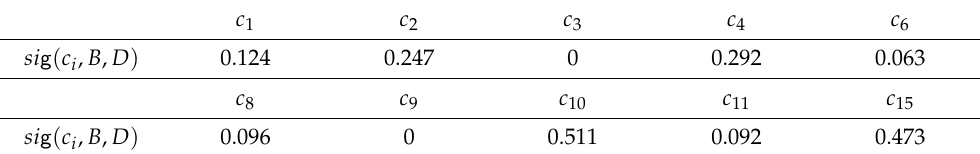
Table 6. Classification ability of right drum condition attribute c for B to D .